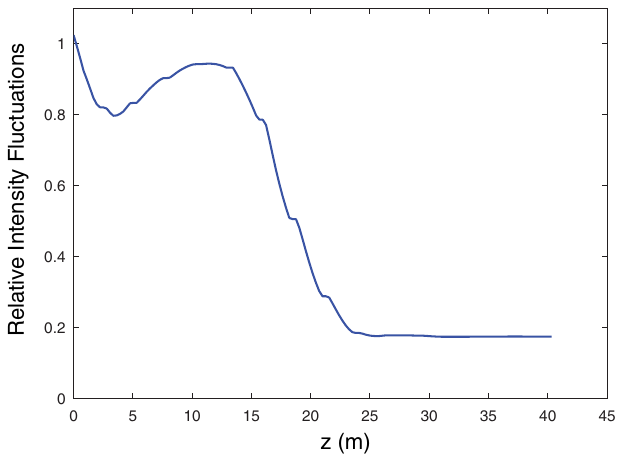
FIG. 14. (Color) Start-to-end, relative intensity fluctuations along the second undulator.